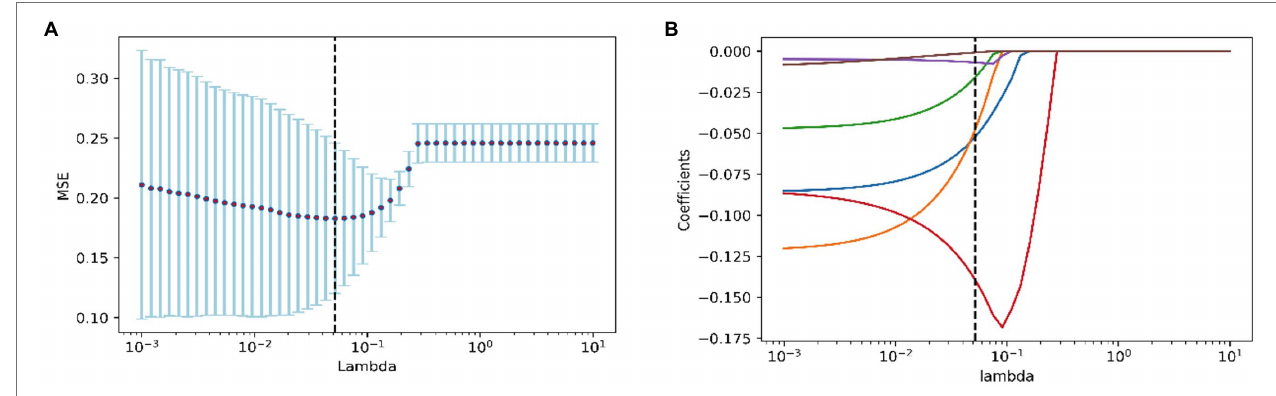
FIGURE 1 | Feature screening of the 5,000 m Race Model. (A) The figure of test MSE by lambda value; (B) the path diagram of lasso regression